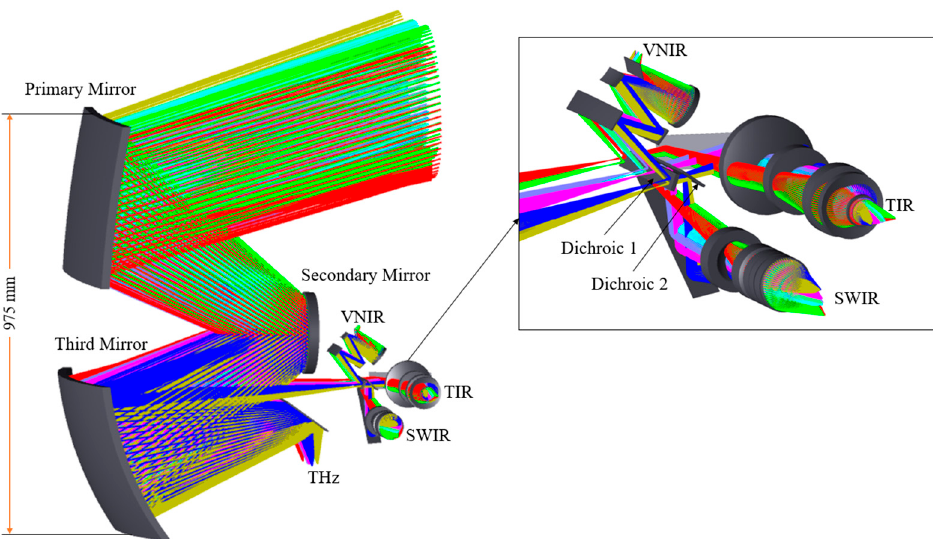
Figure 1. Overall diagram of the optical system.